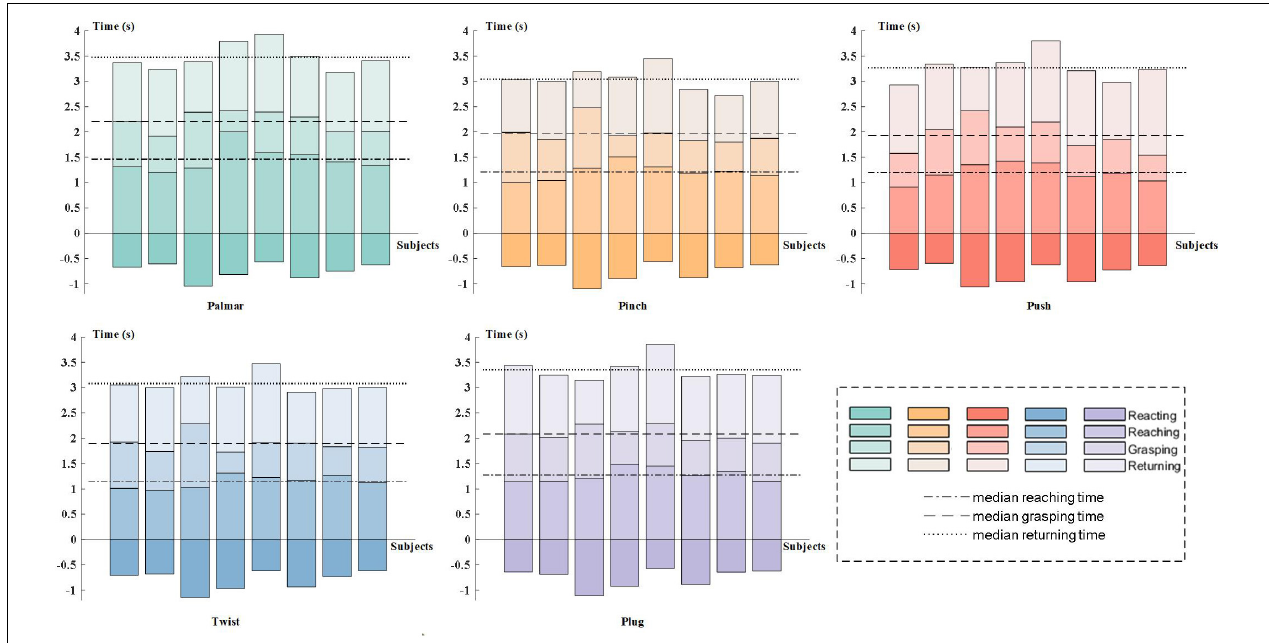
FIGURE 3 | Subject-specific behavioral analysis. In each subgraph, subjects are represented on the horizontal axis in ascending order of subject number from left to right. The 0 s is the subject-specific movement onset. The color tone from dark to light corresponds to the four stages of reach-and-grasp action: reacting phase, reaching phase, grasping phase, and returning